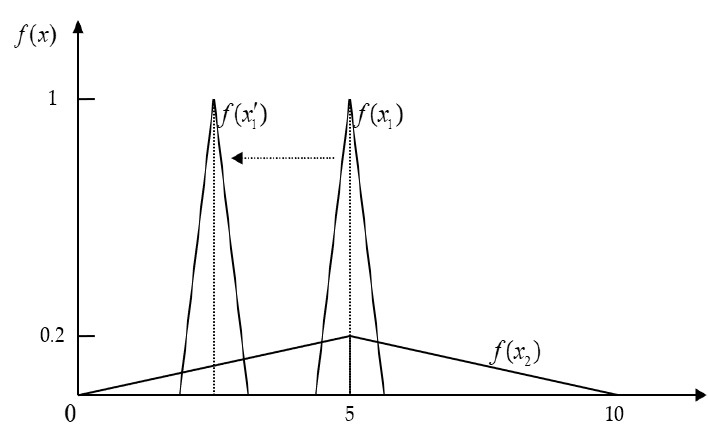
Figure A1. The concept of finding the indifference ratio. A A (with the same mean and A has the smaller spread), and It is obvious that 1 2 1 ( ) f x to the left by decreasing ( ) E A until the expert cannot figure out then we move 1 1 ( ) ( ) u A u A in this situation. Based on our which one is better, i.e., we view 1 2 Figure ( ) 4.6 E A , then ( ) ( ) u A u A and 0.25 − . The results experiments, when the 1 1 2 are described in Figure A2.